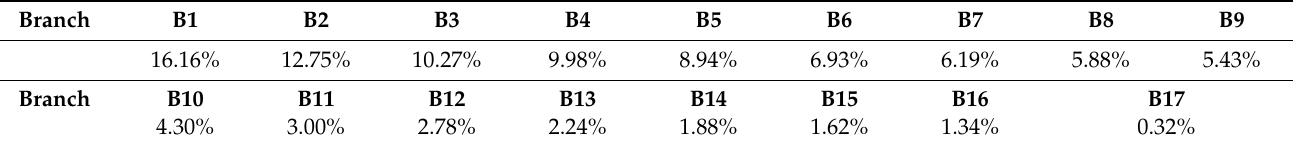
Table 2. The costs of liquidated branches of SRK S.A. subjected to statistical analysis.